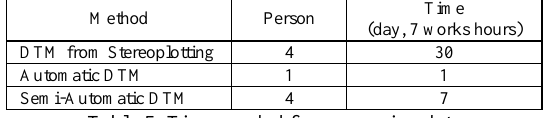
Table 5. Time needed for processing data